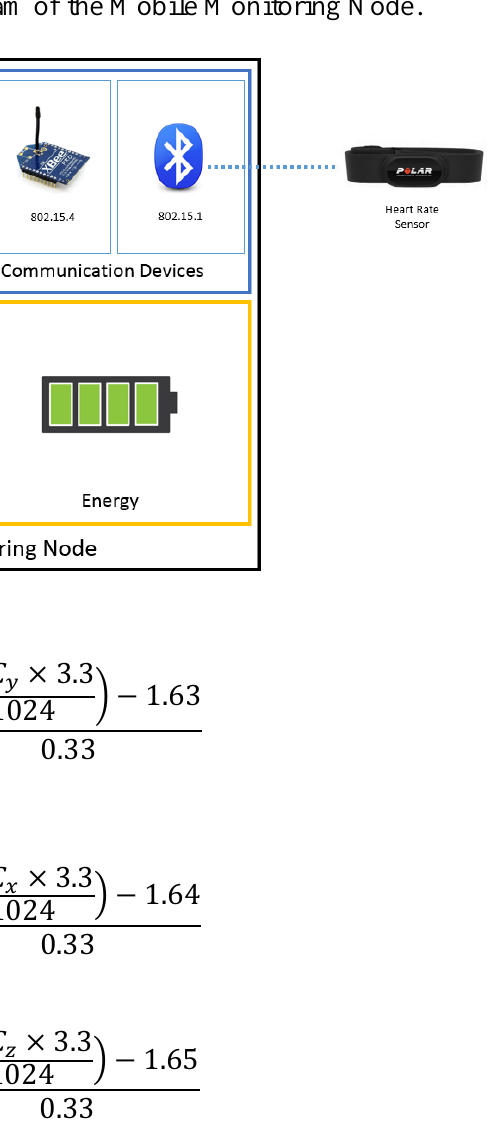
Figure 2. Block diagram of the Mobile Monitoring